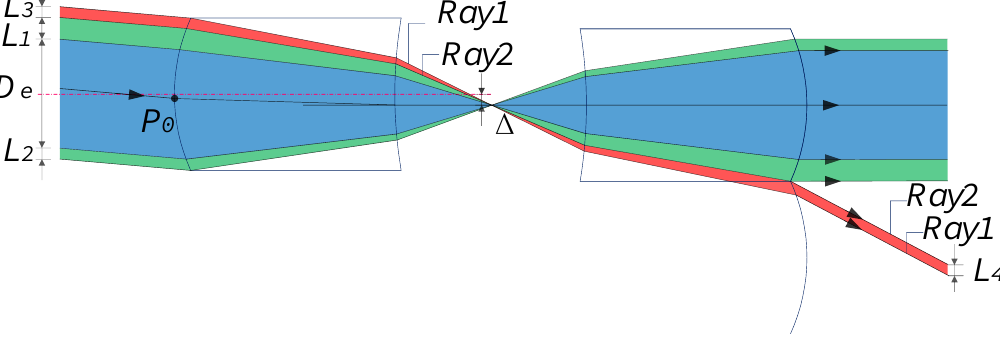
Figure 3. Schematic of MLA system at any swing angle. When the field angle continues to increase to the maximum, the lower edge of the imaging light reaches the lower side of the microlens unit, Type 1 stray light under De gradually disappears, and Type 2 stray light gradually increases, as shown in Figure 4.